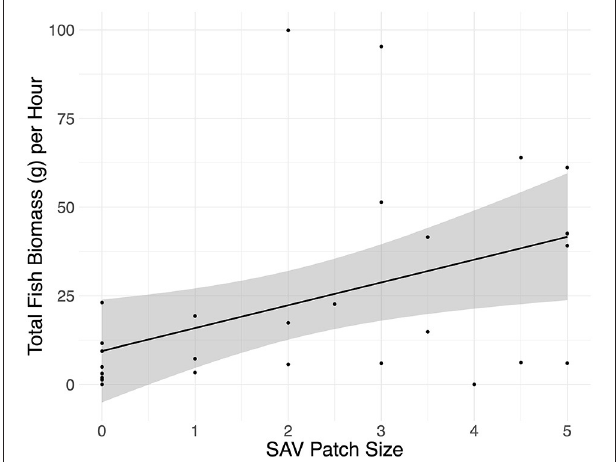
FIGURE 1 | Total fish biomass caught per hour in the fyke nets plotted against SAV patch size with the linear model method. SAV patch sizes were estimated based on an index of 0–5, with 0 being a bare habitat and each increase of 0.5 in the index being equivalent to an approximated increase in patch size of 0.75m by 0.75